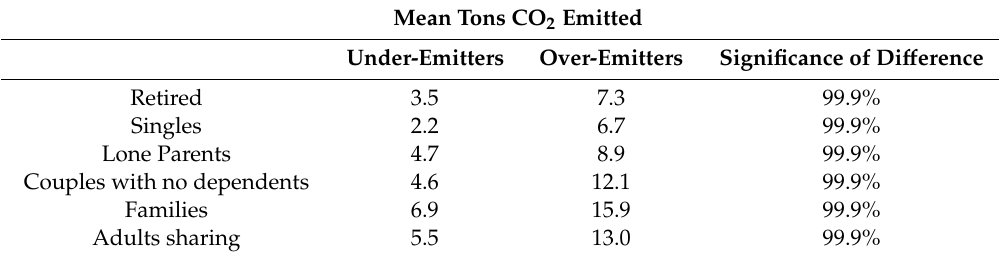
Table 1. Mean total household emissions (home and road fuel in tons CO 2 ) by household type: those in poverty.